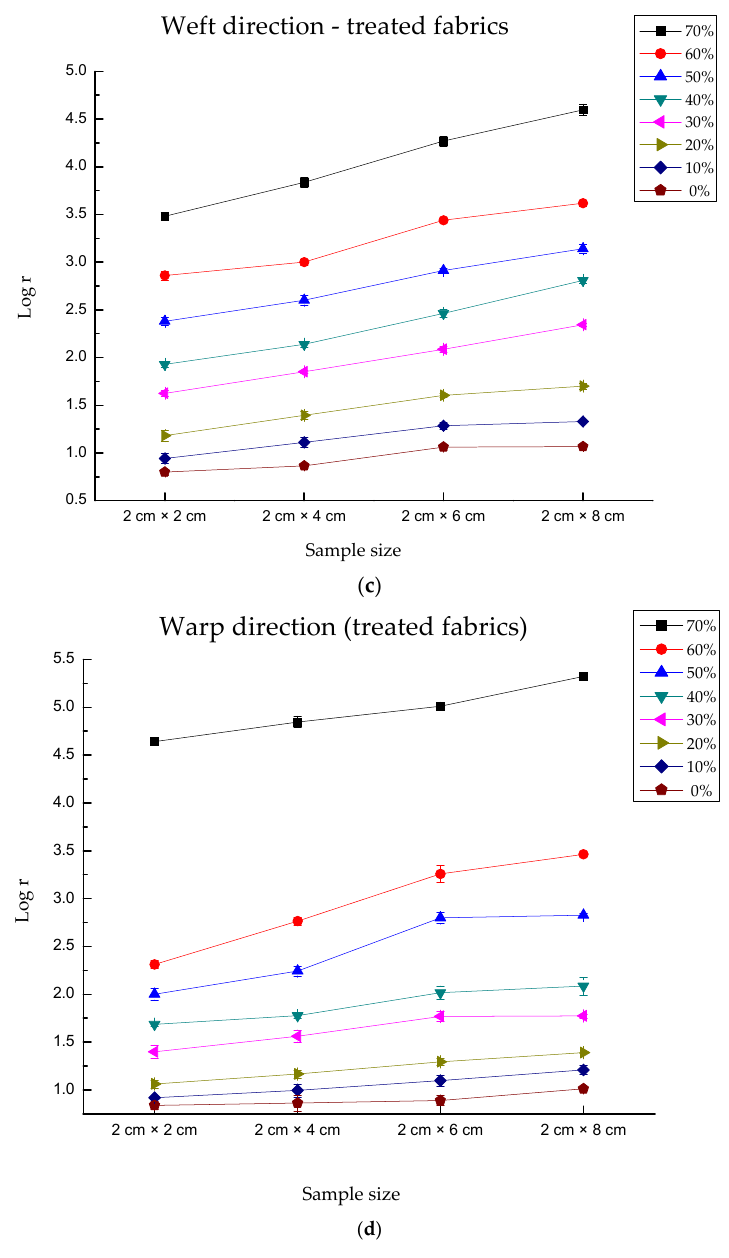
Figure 7. The results of electrical resistance of fabric as a function of sample size. It is found the weft direction of treated fabric had a more stable property.